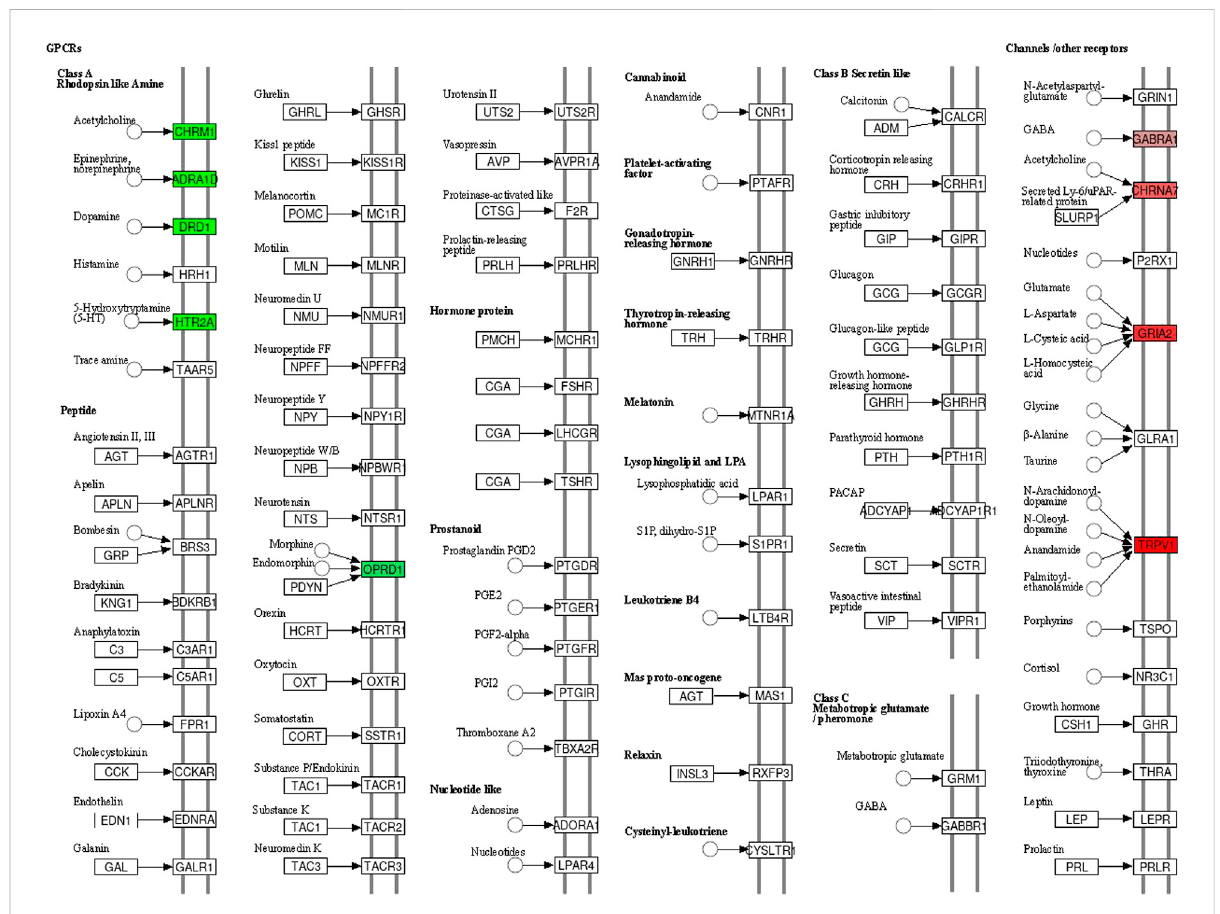
FIGURE 8 Speci fi c action mechanism of enriched genes in neural activity ligand receptor interaction signal